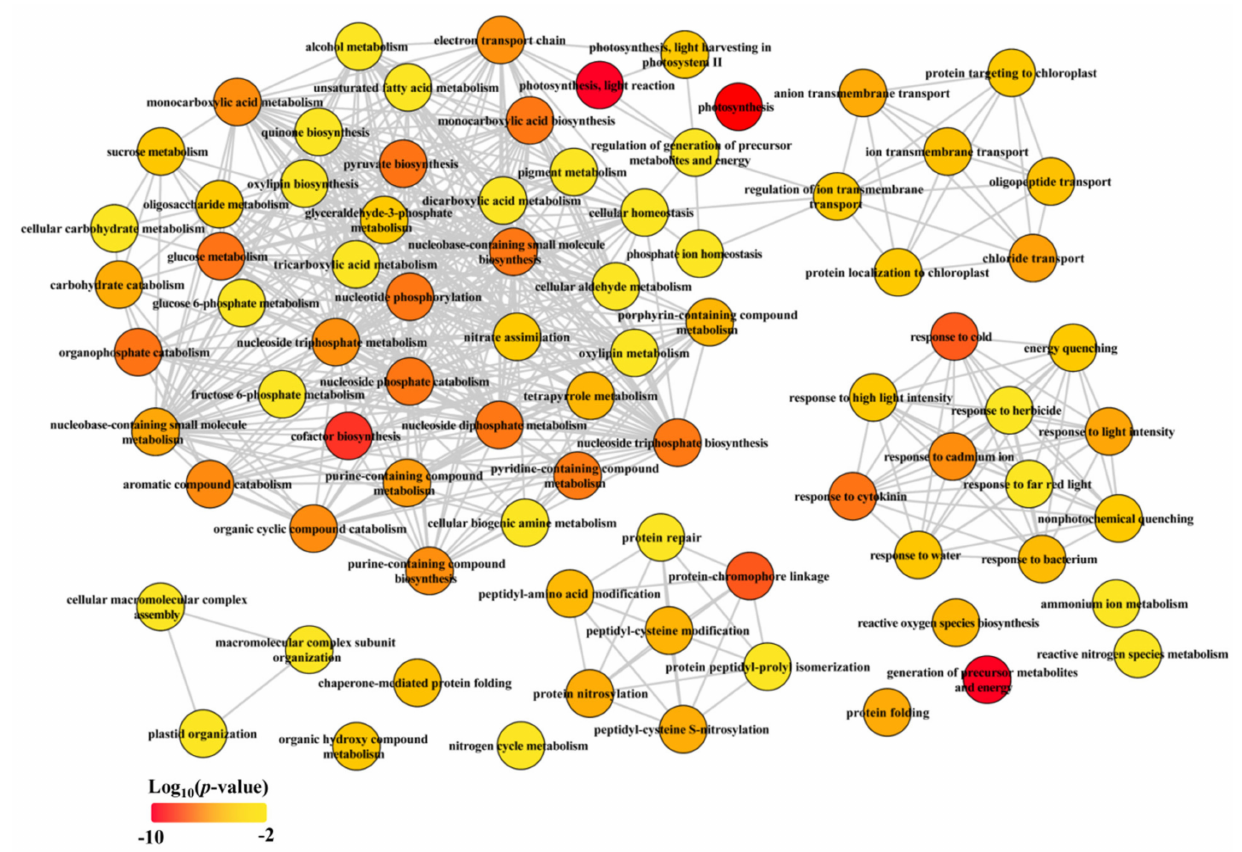
Figure 3. Biological process of GO term analysis of common genes (CGs). The GO term analysis was conducted in R with package “clusterProfiler”. The full list of significant GO terms (see Table S4) assigned into biological process were subjected in REViGO (http://revigo.irb.hr/, accessed on 17 January 2020) to redundant GO terms and visualized in